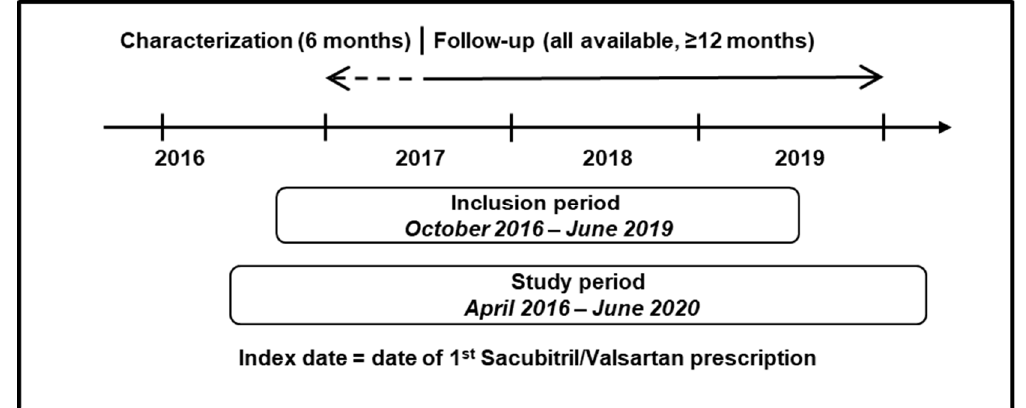
Figure 1. Study design. The study period was between 1 April 2016 and 30 June 2020, and the inclusion period was between 1 October 2016 and 30 June 2019. There was a characterization period of 6 months before the index date (the date of the first prescription of sacubitril/valsartan), and all patients were followed up for at least 12 months from the index date to June 2020.